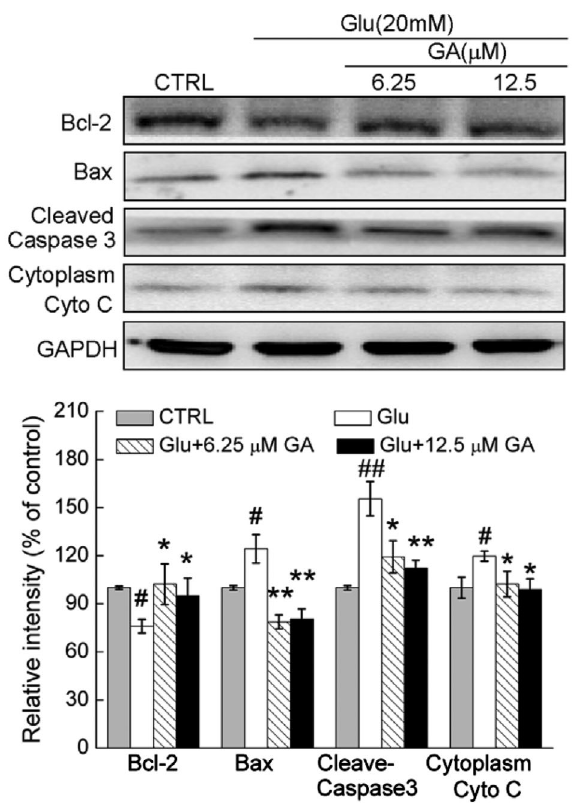
Figure 3. Glycyrrhizic acid (GA) restored the apoptotic alterations of apoptosis related proteins (Bcl-2, Bax, cleaved caspase 3 and cytoplasm Cyto C) caused by glutamate (Glu). Differentiated PC12 cells were pre-treated with GA for 3 h and then co-treated with Glu for another 24 h. Quantification data were normalized by GAPDH. Data are reported as a percentage (means±SD) of that from corresponding control cells (CTRL) (n=3). # P , 0.05, and ## P , 0.01 vs CTRL; *P , 0.05 and **P , 0.01 vs Glu-treated cells (one-way ANOVA followed by Dunn 9 s